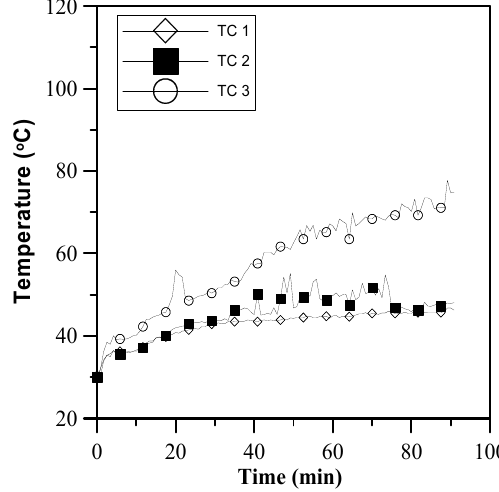
Figure 9. The experimental photos of the important observations. Figure 10a–d shows the heating curves for all points inside the wall/door furnace. The experimental results showed that all of the temperatures were within the heating curve range specified in CNS 14803 [17]; however, the heating rates at each position were not consistent, so the heating on the curtain was uneven. The combustion and pressurization processes in the furnace expanded and bent the curtain externally.